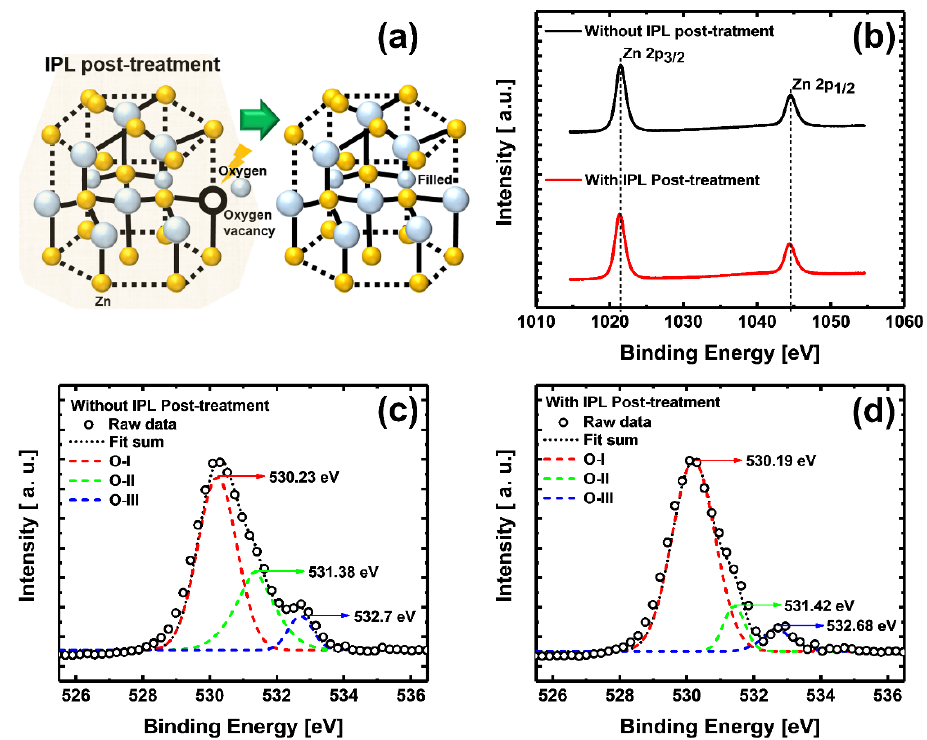
Figure 2. ( a ) Oxygen vacancy in the ZnO structure is filled with oxygen by intense-pulsed light (IPL) post-treatment. ( b ) Zn 2p XPS spectra of ZnO nanoparticle (NP) film (black) without and (red) with IPL post-treatment. O 1s XPS spectra of ZnO NPs film ( c ) without and ( d ) with IPL post-treatment.